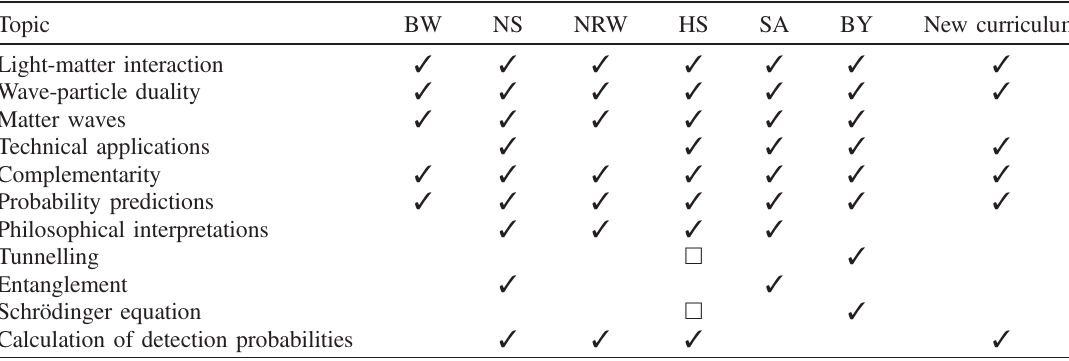
TABLE I. Quantum physics topics in the curricula of Baden-Wuerttemberg (BW), Lower Saxony (NS), North Rhine-Westphalia (NRW), Hesse (HS), Saxony (SA), and Bavaria (BY) adapted from Staderman et al. [31] without atomic physics items. Mandatory coverage of the subject in secondary school ( ✓ ), and optional study ( □ ), respectively, are indicated. The last column allows a comparison between our new curriculum based on coincidence and correlation experiments with heralded photons, on the one hand, and the traditional curricula in terms of contents covered at German secondary schools, on the other hand. The study reported in this article was conducted at Bavarian schools. Since the different teaching approaches vary in terms of the topics covered to some extent, it is not possible to make a meaningful comparison between the approaches solely on the basis of learning gains. In this article, we will therefore refer to learners ’ conceptions of such quantum physics concepts that are taught in all introductory courses on quantum physics, irrespective of the content or didactic focus as discussed in Sec.